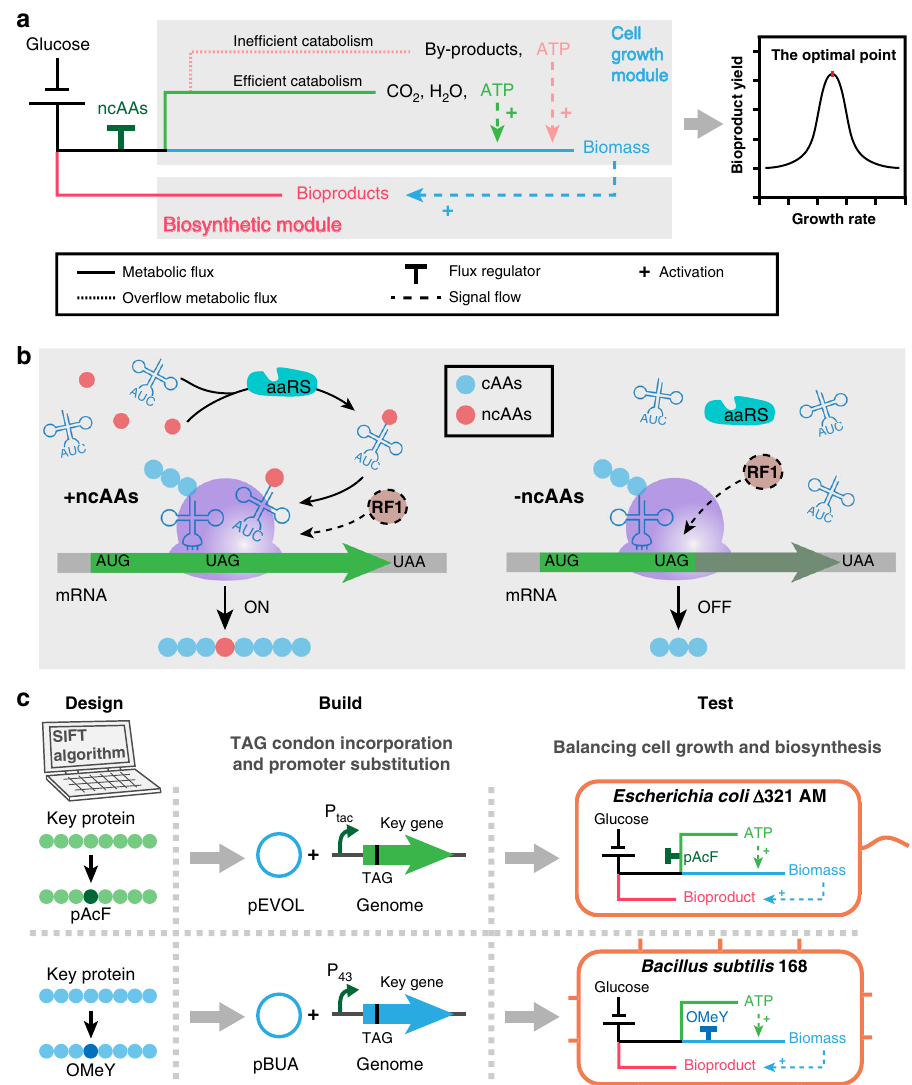
Fig. 1 Balancing cell growth and product synthesis based on genetic code expansion. a Metabolic fl ux distribution during cell growth and biosynthesis. Theoretically, the balance between cell growth and product synthesis can be achieved by regulating the distribution of metabolic fl uxes to obtain optimal yield. b Utilization of the non-canonical amino acid (ncAA) incorporation tool to build a molecular switch. Translation can be interrupted when an amber stop codon (TAG) is inserted into the gene sequence of interest (green arrow) in the absence of ncAAs. However, after ncAAs are added, aminoacyl-tRNA synthetase (aaRS) can catalyze ncAA-loading of tRNAs (blue clover-leaf structure), which are able to restore gene expression. While peptide chain release factor RF1 was depleted in genetically recoded E. coli Δ 321AM, competition between RF1 and aminoacyl-tRNA molecules may have reduced the ef fi ciency of the ncAA system in non-genome-recoded B. subtilis 168 (the dotted circle). c Work fl ow of the GCE-CGBBE strategy in E. coli and B. subtilis . First, amber stop codon (TAG) substitution sites of key genes that control cell growth were designed based on the SIFT algorithm. Next, strains harboring ncAA- incorporation tools were constructed to achieve regulatory expression of genes with amber stop codon insertion. Finally, cell growth and product balance were tested in two of the best-studied Gram-negative and Gram-positive bacteria, i.e., genetically recoded E. coli Δ 321AM and non-genome-recoded B. subtilis 168. cAAs, canonical amino